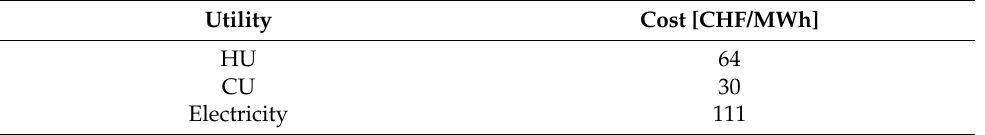
Table 4. Utility costs of Case 2; HU and CU are the hot and cold utilities.